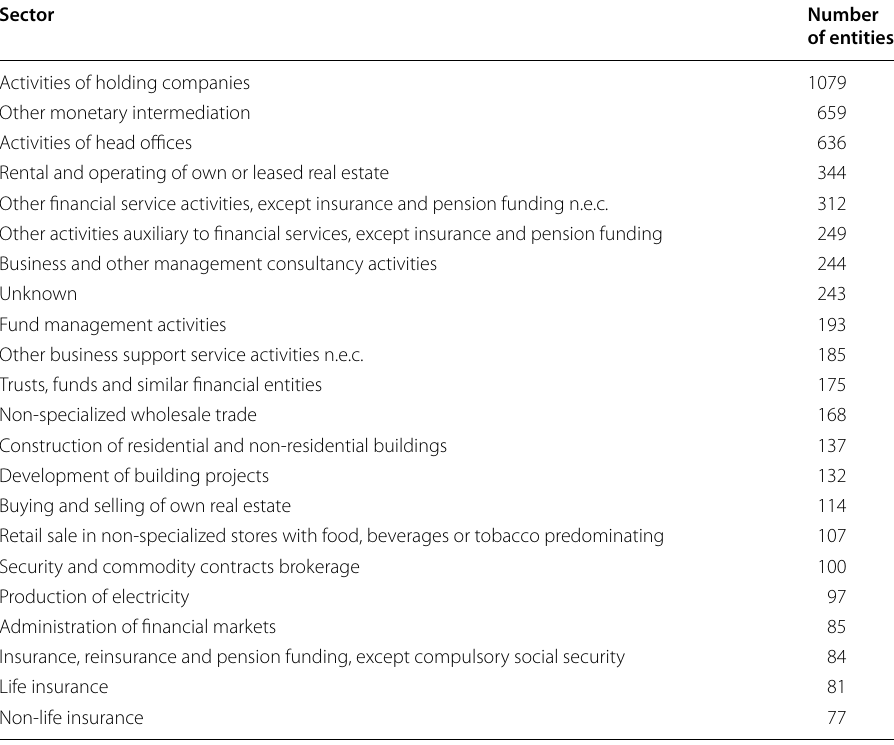
Table 6 Top 20 influential sectors using coreness using RIG